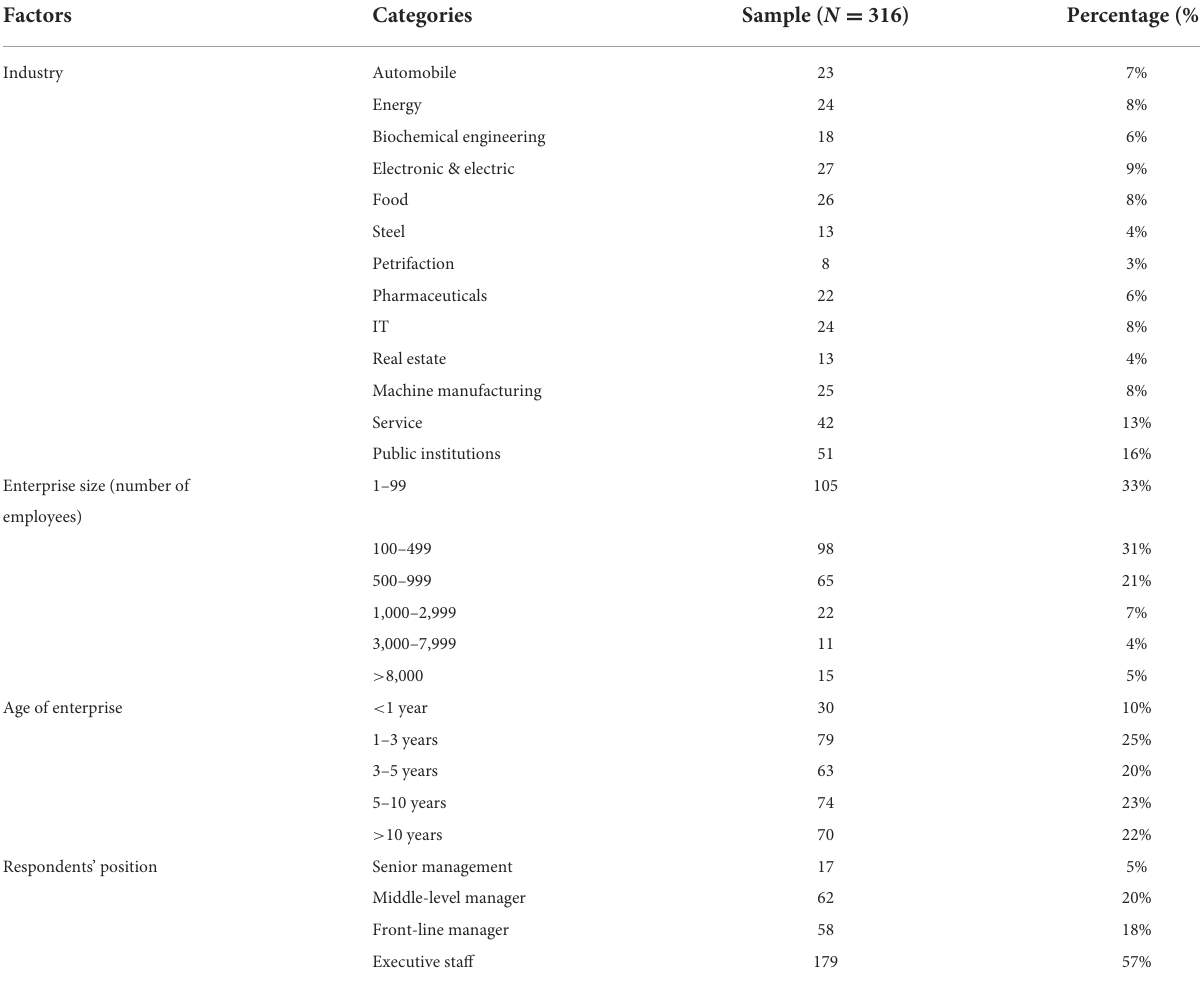
TABLE 3 Profile of research